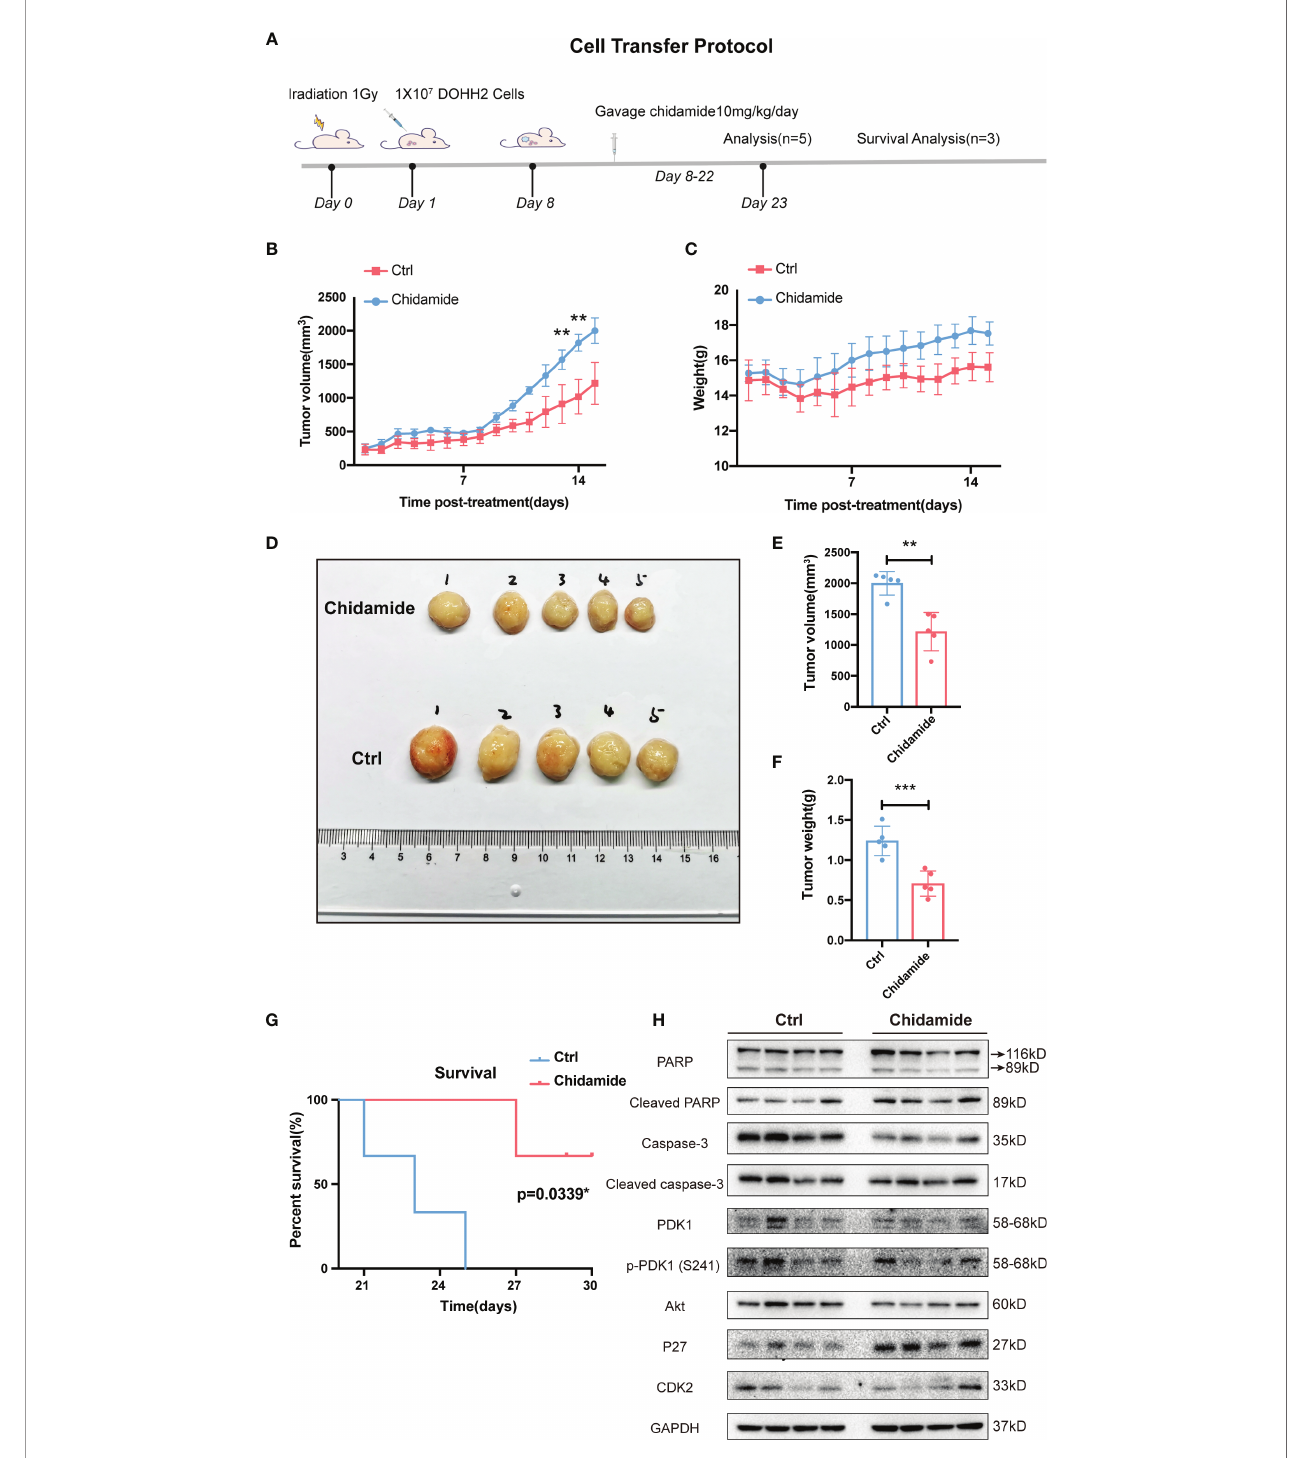
FIGURE 7 | Effect of chidamide on tumor growth in xenograft mouse models. (A) Cell injection protocol in a FL tumor xenograft model. Tumor volumes (B) and body weights (C) of mice were measured daily and presented as mean±S.D. (D) Images of tumors from DOHH2-bearing xenograft mice after the indicated treatments (n=10). Tumor volumes (E) and weights (F) in the control and chidamide groups were compared to evaluate the treatment response to chidamide. (G) Kaplan Meier overall survival (OS) curves of tumor-bearing xenograft mice. (H) Chidamide suppressed the PDK1-Akt-P27-CDK2 signaling pathway in vivo . The protein levels of PDK1, AKT, P27, CDK2, PARP, cleaved-PARP, caspase3 and cleaved-caspase-3 were determined by Western blot. (** p < 0.01; *** p <